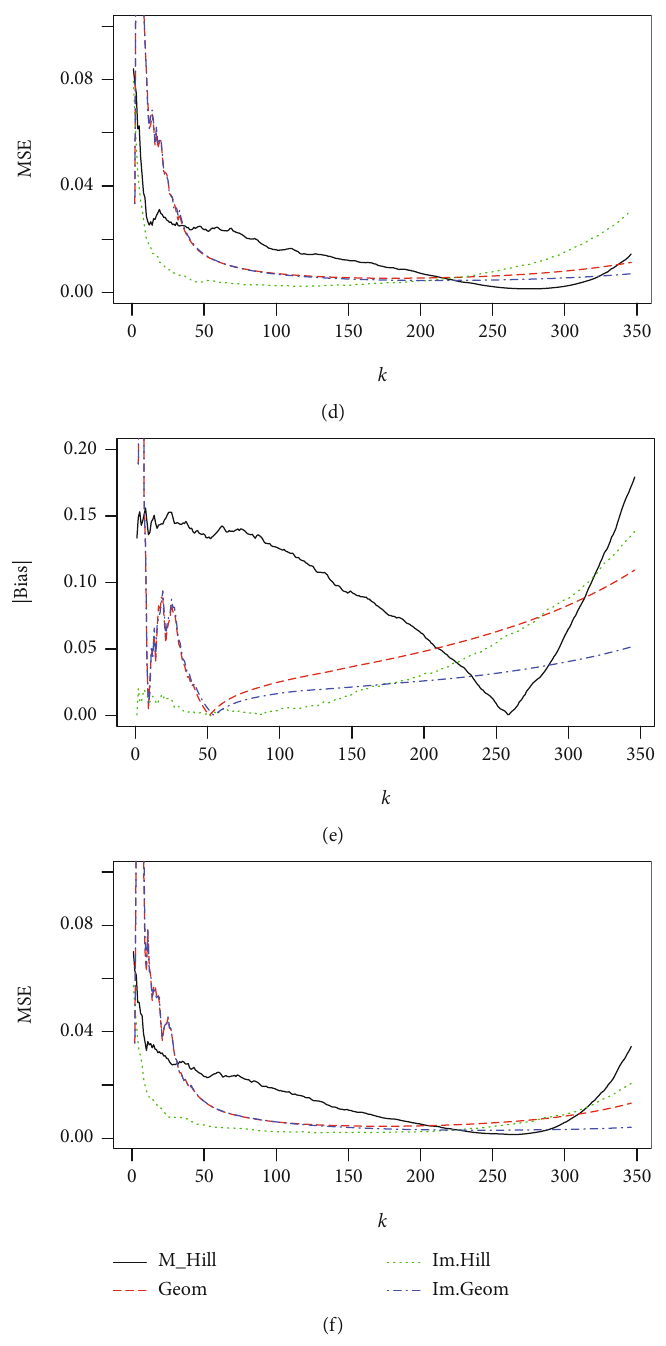
Figure 3: Results of ̂ ξ ð k Þ from Burr distribution with n = 500 . (a, c, and e) Absolute bias. (b, d, and f) MSE. (a, b), (c, d), and (e, f) are 10%, 30%, and 60% missingness,